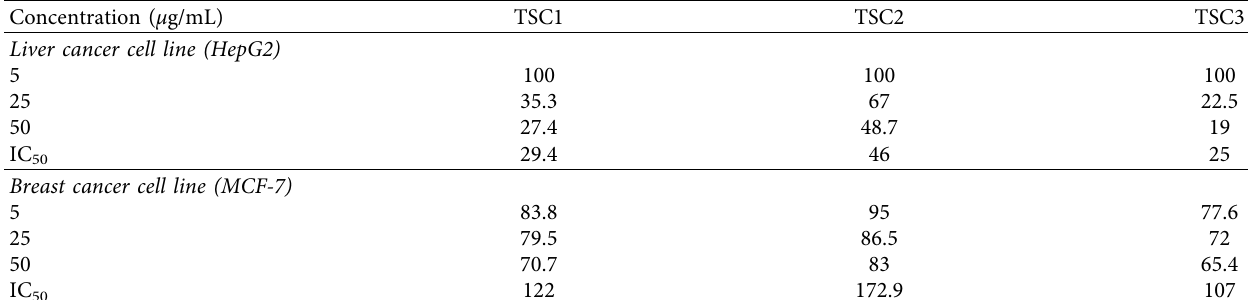
Table 4: Antitumor activity of the synthesized thiosemicarbazone